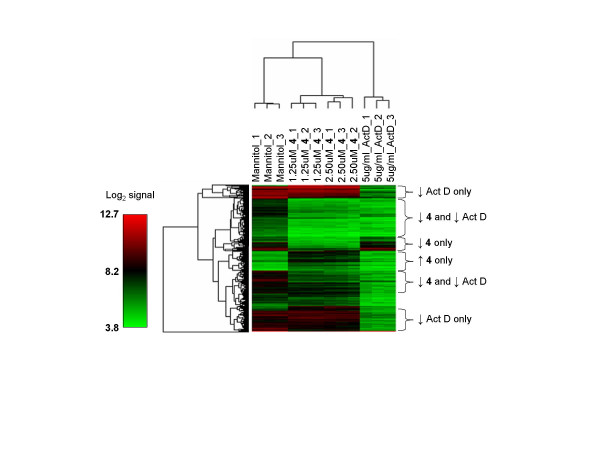
Hierarchical clustering analysis of gene expression data from drug-treated A549 cell cultures. The dendrograms were generated based on average linkage hierarchical clustering of expression data from 422 probe tilings whose coefficient of variation was greater than 0.15 across all groups. Data from untreated (mannitol) and drug-treated [(sapphyrin PCI-2050 = 2050) or (actinomycin D = ActD)] A549 cultures are provided in triplicate using the noted concentrations. The relative expression levels (↑ = up-regulated, ↓ = down-regulated) of selected gene groupings in drug-treated versus control cells are provided on the right side of the figure. Note that this reflects relationships only within the subset of genes used for cluster analysis.